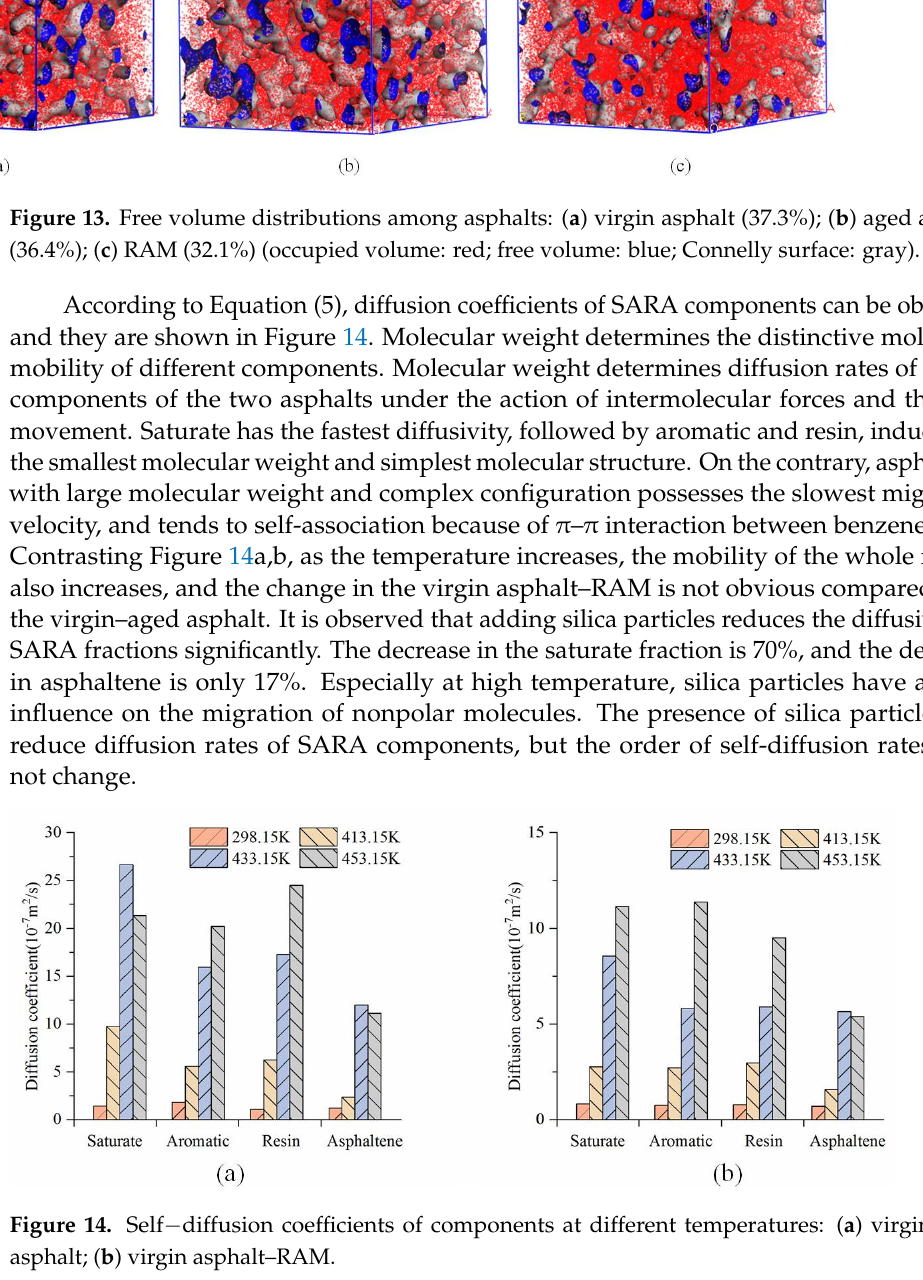
Figure 12. MSDs of SARA components: ( a ) asphaltene; ( b ) resin; ( c ) aromatic; ( d ) saturate.